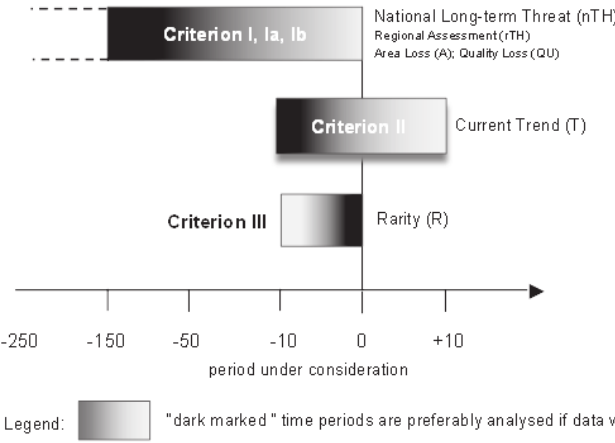
Figure 1. Time frames of the three red listing criteria of the German Red List (Finck et al. 2017). For the long-term evaluation (nTH), mainly anthropogenic spatial (sub criterion AL) and qualitative (sub criterion QUL) changes over the last 50–150 years (sliding time frame) are assessed for the major regional landscape units. The estimation of the ‘Current Trend’ (T) is based on development over the last ten years and a forecast for the near future (maximum ten years). A higher risk of loss is basically assumed for habitat types which are ‘Extremely Rare’ at present (R). The latter includes both ‘natural’ rarity as well as rarity as a result of human